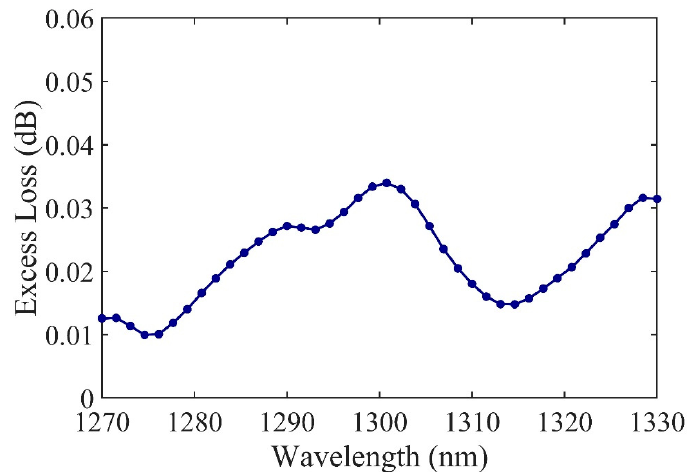
Figure 6. The simulated EL of the optimal device.